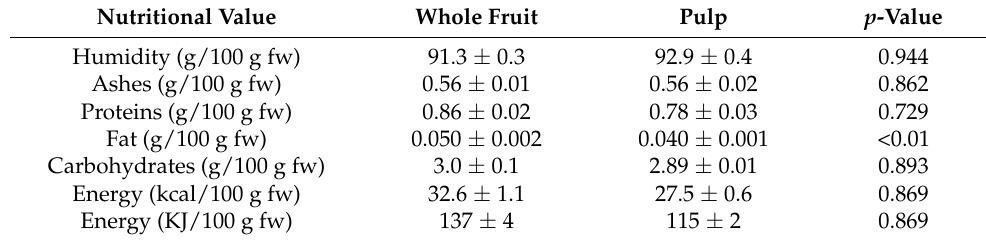
Table 3. Nutritional parameters of the whole fruit and pulp of Solanum melongena L. (mean ± SD). Nutritional Value Whole Fruit Pulp p